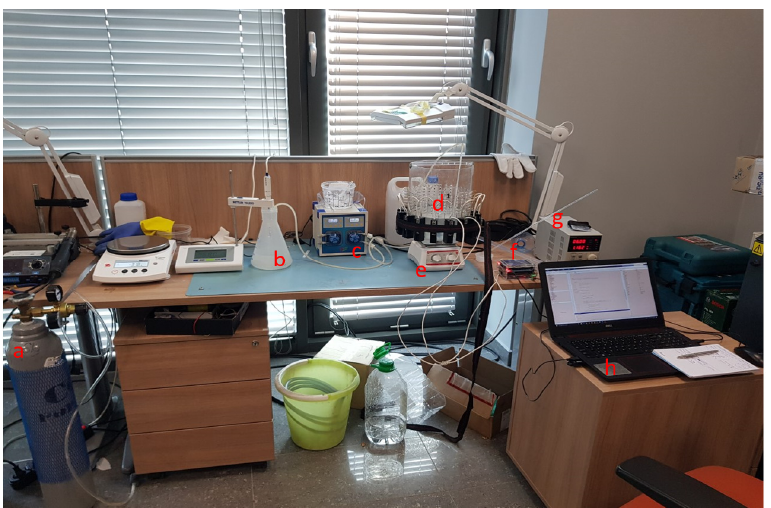
Figure 8. Photo of the batch crystallisation experimental apparatus. ( a ) Carbon dioxide tube for gas injection; ( b ) reagent vessel filled with sodium carbonate solution (reagent); ( c ) electronic peristaltic pump; ( d ) receiving tank filled with calcium chloride solution; ( e ) IKA Midi 1 digital magnetic stirrer; ( f ) tomographic device developed by NETRIX company; ( g ) power supply; ( h ) computer unit used for running MATLAB code and providing tomographic results.